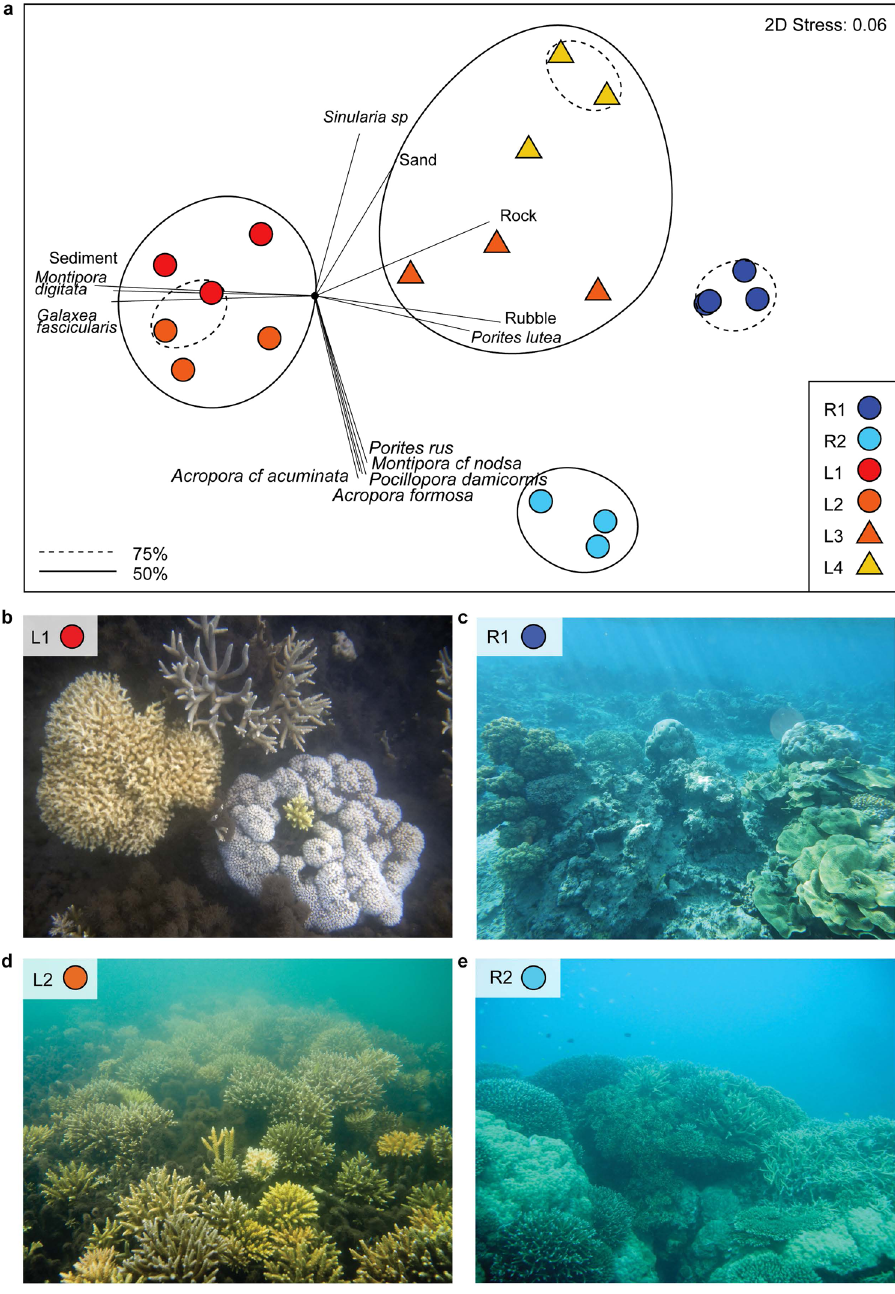
Figure 2. Benthic composition of the Bouraké semi-enclosed lagoon system and reference reef sites. ( a ) A multidimensional-scaling plot of benthic data per sites with 50% (solid) and 75% (hashed) similarity shown. Pearson’s correlations exceeding R > 0.6 between benthic taxa are represented as vectors in black. ( b–e ) Typical benthic scenes of the lagoon sites L1 ( b ) and L2 ( d ), the exposed reference reef site R1 ( c ), and sheltered reference site R2 ( e